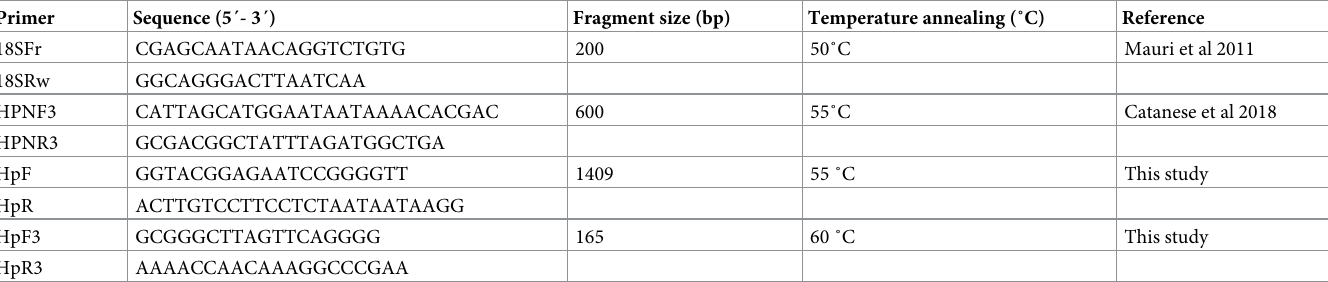
Table 2. Characteristics of the primers used for